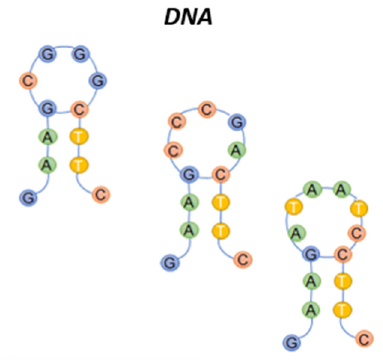
Figure 4. Sketch of Hairpin DNA structures with different loop dimensions.